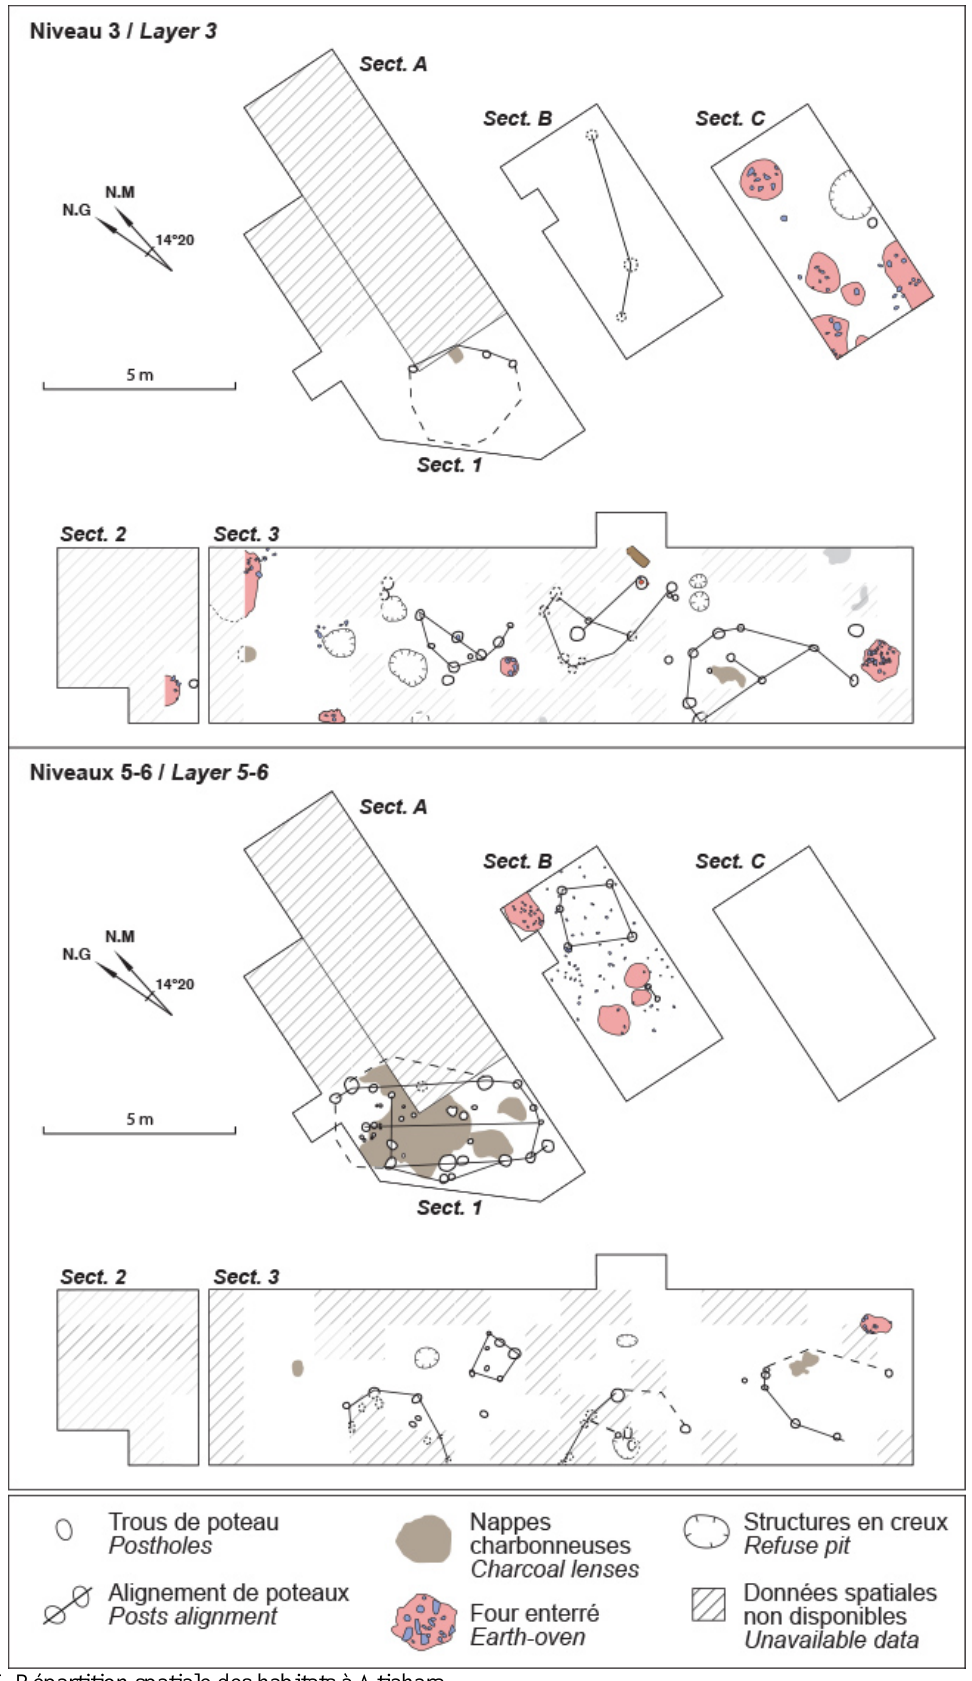
Figure 5. Répartition spatiale des habitats à Atiahara. Figure 5. Plan of the Atiahara site